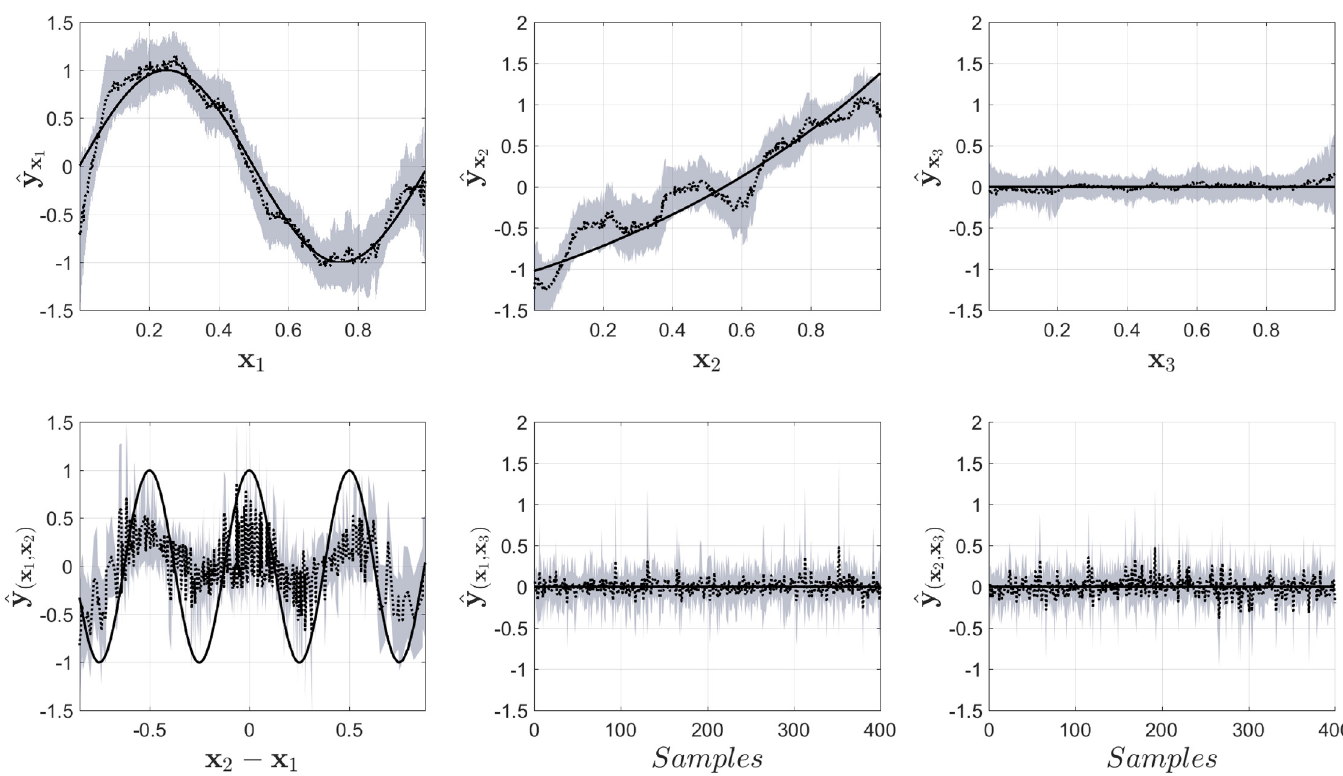
Fig 6. Output of the model for the decomposition using COSSO-II and non-correlated inputs. The black solid line represents the true component, the dotted black line represents the mean for the estimations using NObSP, and the gray area represents the 95% confidence interval obtaining using bootstrap.